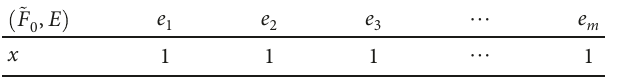
Table 4: Fuzzy soft set F